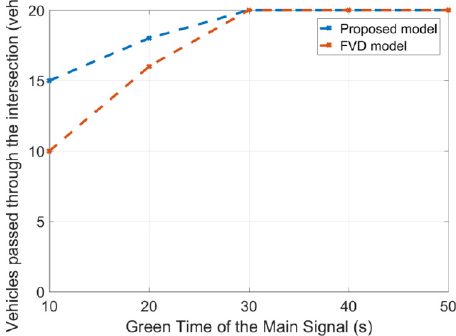
Figure 4 Effect of green time of the main